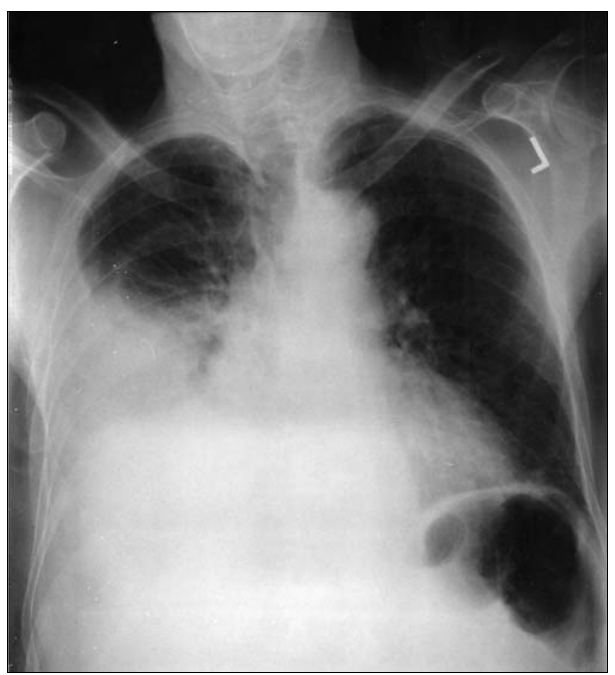
Figure 1) Chest radiograph demonstrating right middle and lower lobe consolidations with effusion